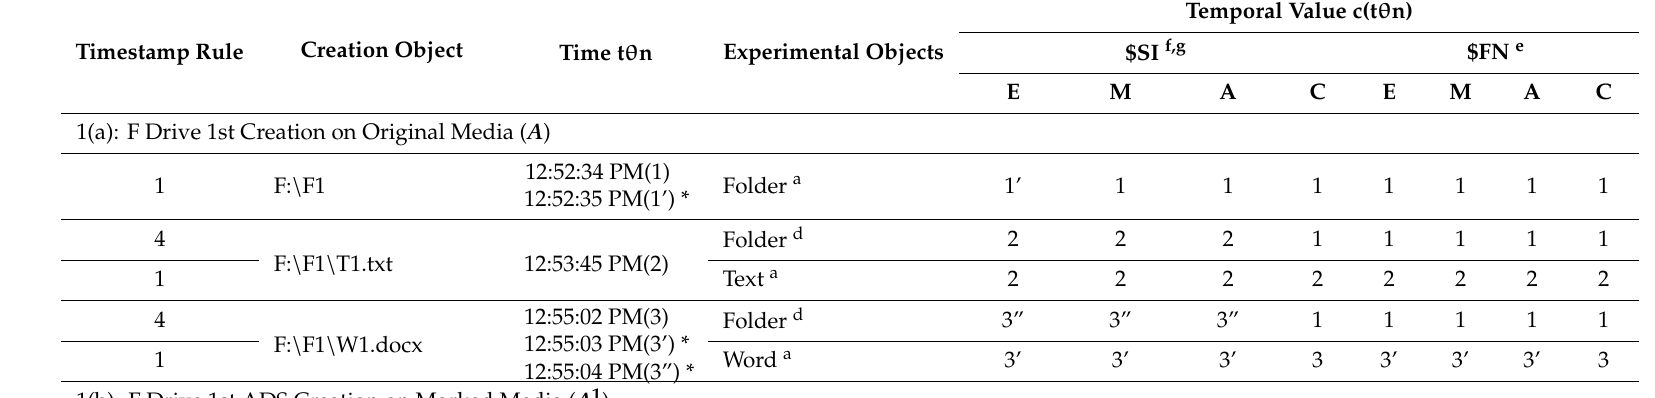
Table 6. Functional reconstruction on cover media creation (Stage